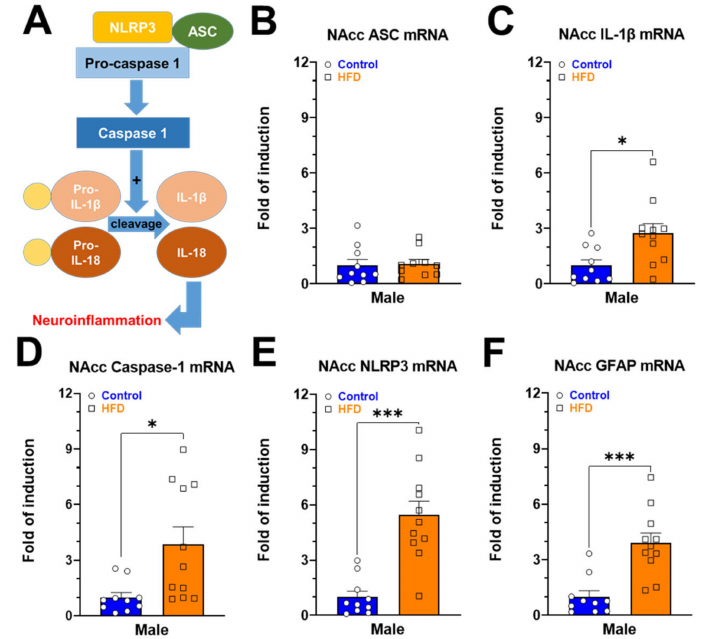
Figure 3. Gene expression patterns of neuroinflammatory markers ( A – F ) in NAcc of normal weight and obese rats. All data are normalized for 18S expression levels within the same sample. Results